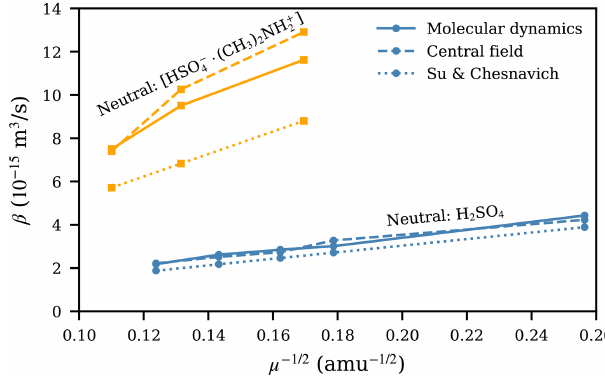
Figure 6. Collision rate coefficient β plotted as a function of µ − 1 / 2 for collisions involving H 2 SO 4 or [HSO − from molecular dynamics trajectory simulations, the central field model using the attractive potential fitted to the PMF, and the Su and Chesnavich (1982)